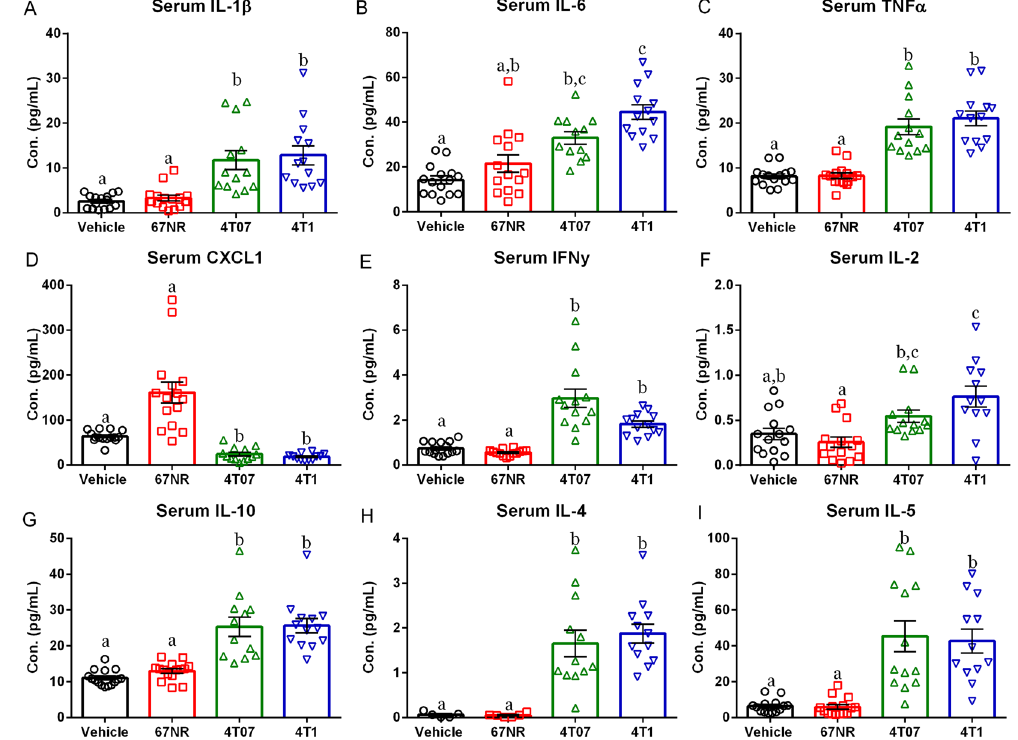
Figure 2. 4T07 and 4T1 Tumors Increase Serum Cytokine Concentrations. ( A – I ) Serum protein cytokine concentrations of IL-1 β , IL-6, TNF α , CXCL1, IFN γ , IL-2, IL-10, IL-4, and IL-5 expressed in both vehicle and treatment groups. ( A ) Serum IL-1 β was significantly increased in 4T07 and 4T1 tumors relative to 67NR tumors and vehicles. ( B ). Serum IL-6 was increased in 4T07 and 4T1 tumors relative to vehicles. ( C ) TNF α concentrations were significantly increased in 4T07 and 4T1 tumors relative to 67NR tumors and vehicles. ( D ) Serum CXCL1 was significantly reduced in 4T07 and 4T1 tumors relative to 67NR tumors and vehicles. ( E ) IFN γ concentrations were significantly increased in 4T07 and 4T1 tumors relative to 67NR tumors and vehicles. ( F ) Serum IL-2 was increased in 4T07 and 4T1 tumors relative to 67NR tumors. ( G – I ) Serum IL-10, IL-4, and IL-5 was significantly increased in 4T07 and 4T1 tumors relative to 67NR tumors and vehicles. The measures and tissues were collected 20 days after tumor cell or vehicle inoculation (n = 12–15/group). The data are presented as mean + SEM. Graph bars that do not share a letter are statistically significant different at p <